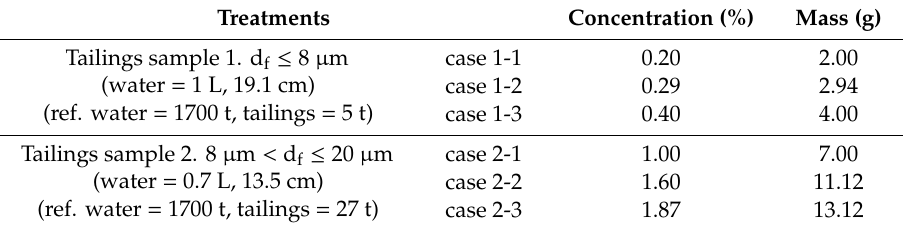
Table 1. Treatments for the manganese nodule settling velocity experiments. Treatments Concentration